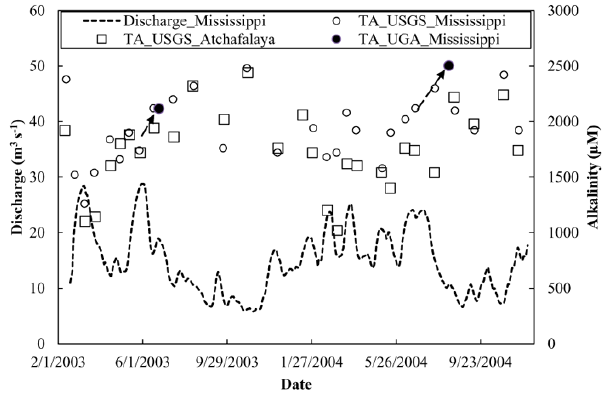
Fig. 1. Temporal variation of the Mississippi River discharge (dashed line) and TA values from the USGS site St. Francisville (site# 07373420, open circles), from the Mississippi River channel (solid circles, this study), and from the Atchafalaya River at USGS site Melville (site#07381495, squares). The two dashed arrows in- dicate increasing rates of TA prior to the cruise periods: 1.7µMd − 1 during 12 May to 24 June 2003 (increasing 75µM) and 6.4µMd − 1 during 22 June to 11 August 2004 (increasing